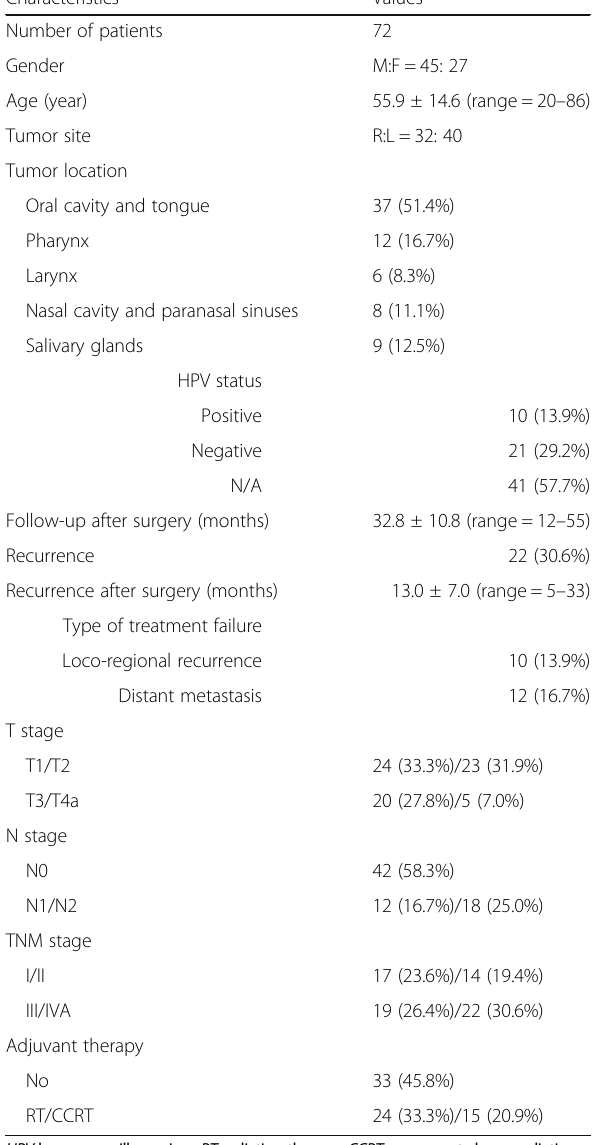
Table 1 Baseline characteristics of